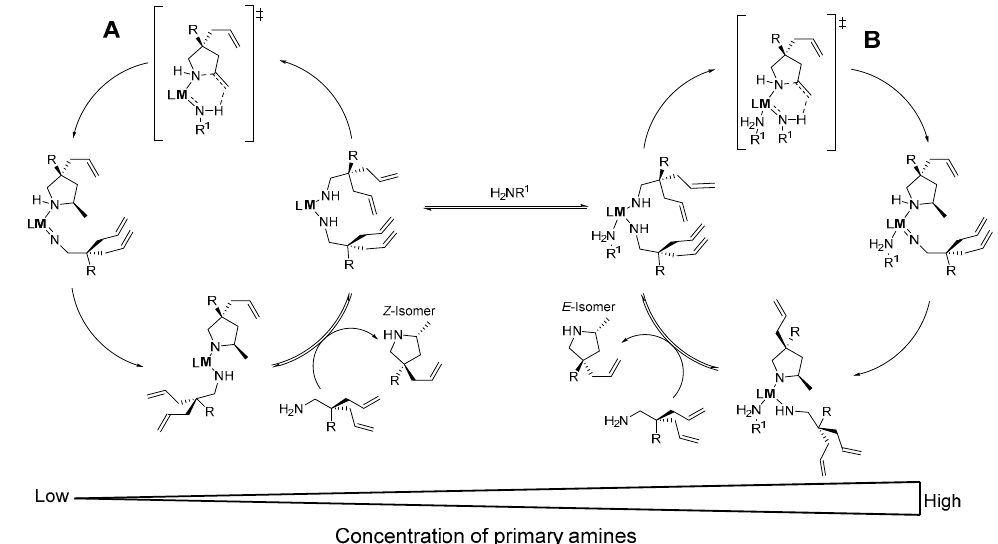
Figure 3. Proposed catalytic cycle explaining the concentration-dependent Z / E selectivity with an exchanging two-site catalytic model [96].